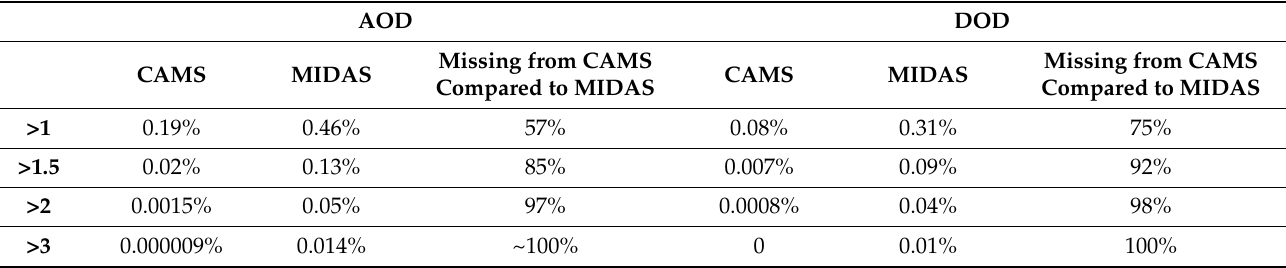
Table 4. Summary statistics of AOD and DOD (from both MIDAS and CAMS datasets) values greater than specific threshold values 1, 1.5, 2 and